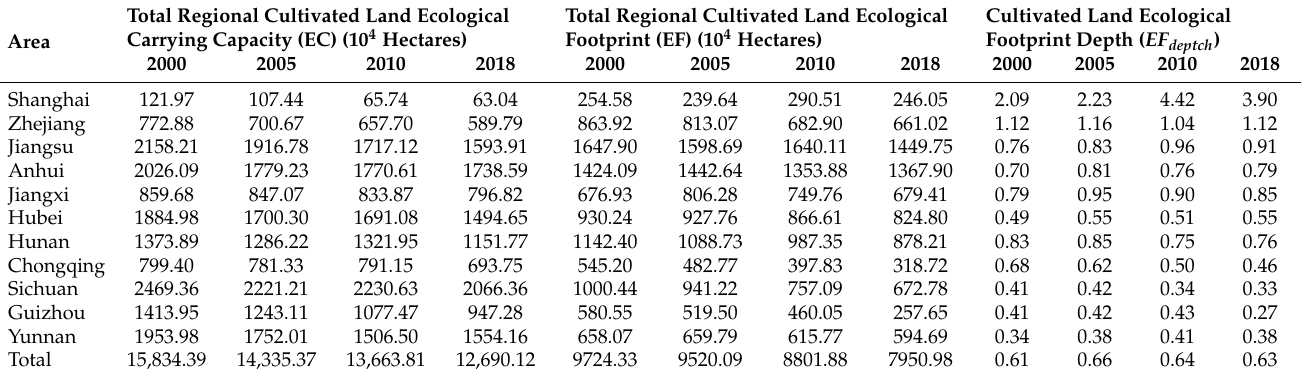
Table 1. Ecological profit and loss of cultivated land in the Yangtze River Economic Belt from 2000 to 2018. Total Regional Cultivated Land Ecological Carrying Capacity (EC) (10 4 Area